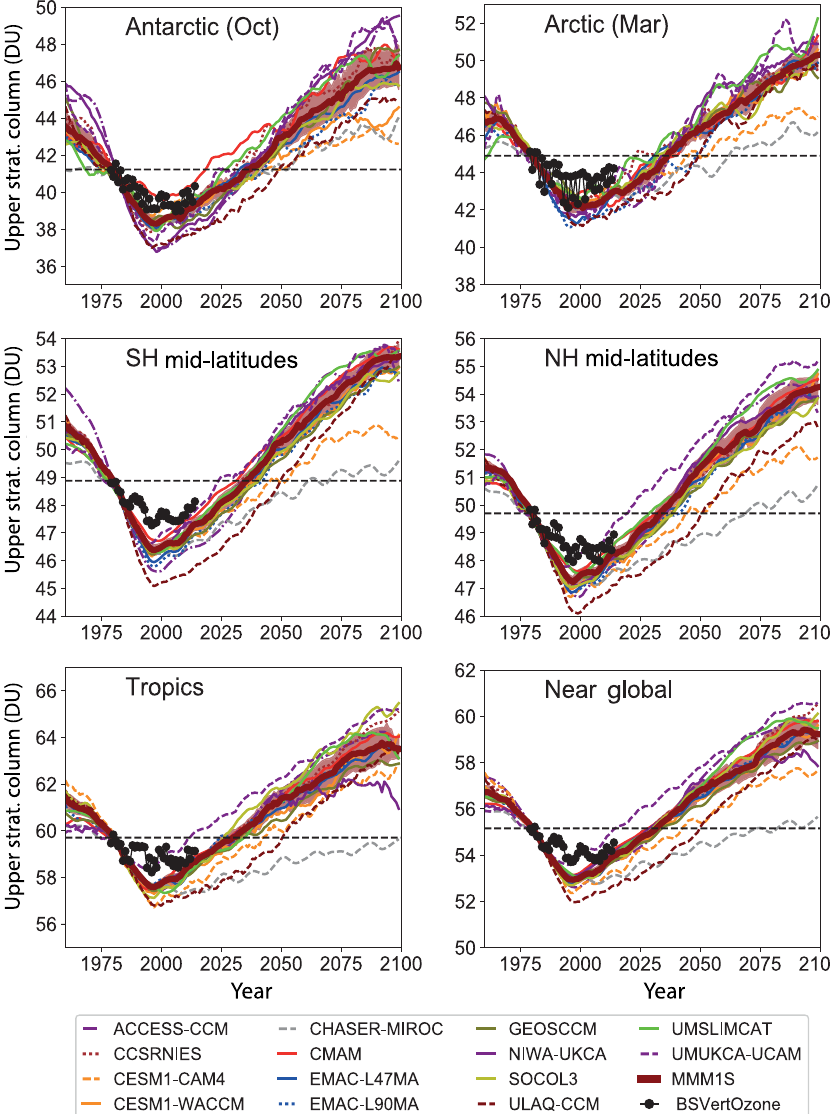
Figure 6. As Fig. 5 but for the upper stratosphere ( ≥